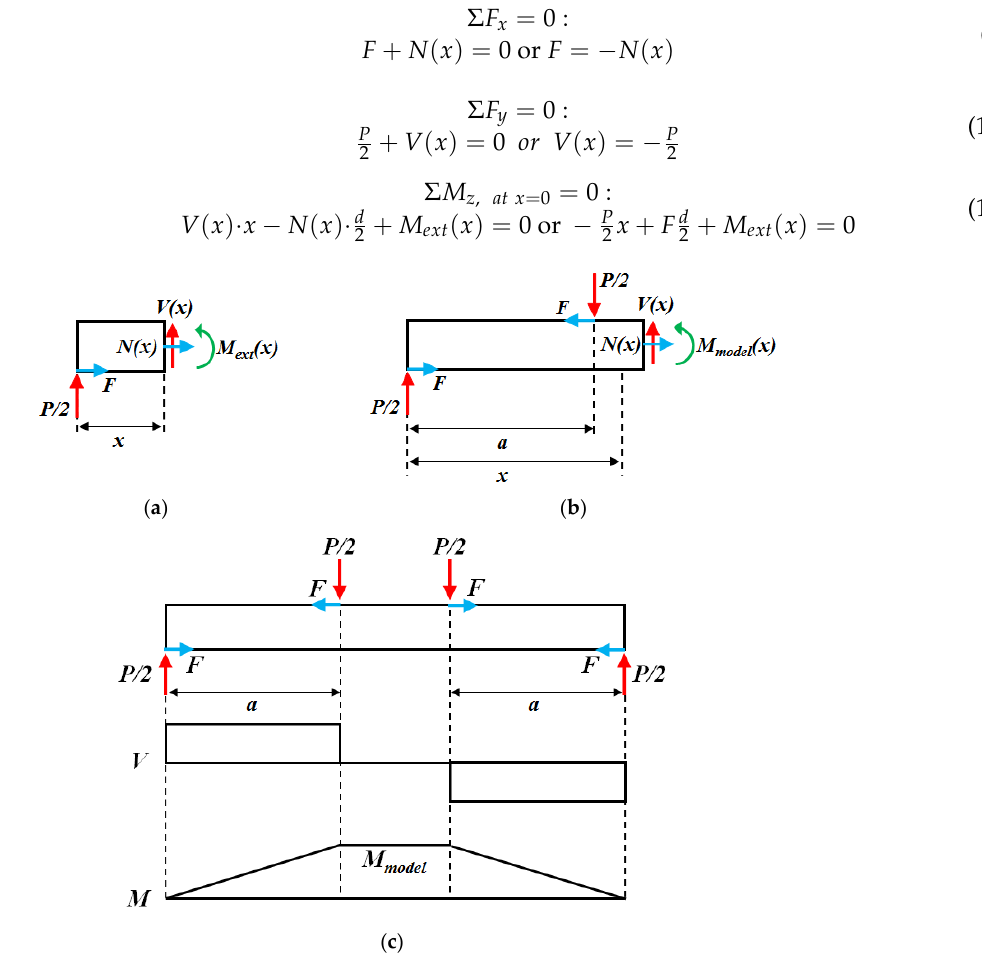
Figure 27. The free-body, shear-force, and bending-moment diagrams: ( a ) FBD when 0 < 𝑥 < 𝑎 ; ( b ) FBD when 𝑎 < 𝑥 < 𝐿/2 ; ( c ) The shear-force and bending-moment diagrams. Figure 27b shows the FBD for 𝑎 < 𝑥 < 𝐿/2 . The equilibrium equations for the FBD are as follows. The ultimate bending moment considering the frictional force (Equation (6)) can be obtained using Equation (14):